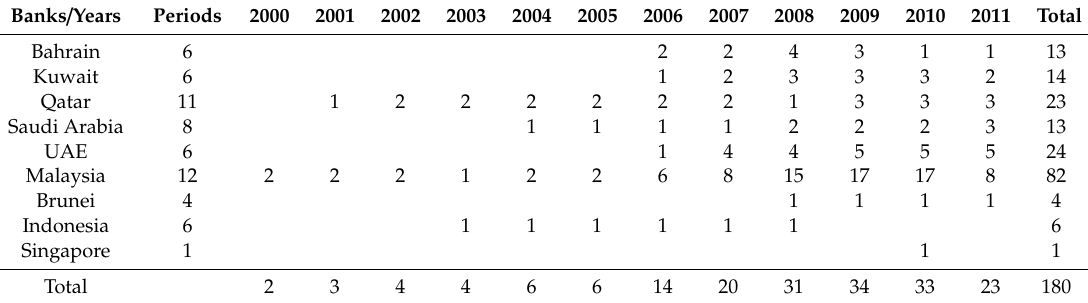
Table A3. The sampling Distribution of Observations by years and